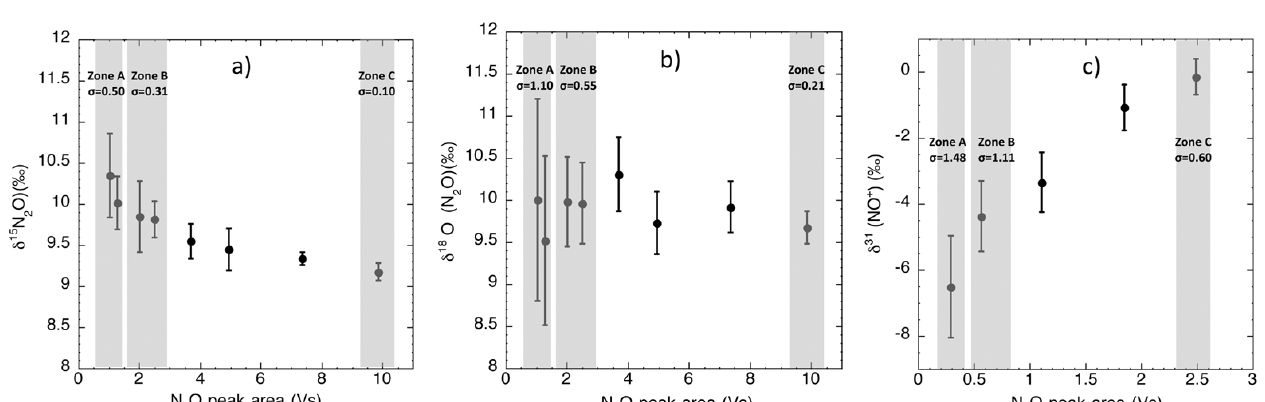
Fig. 3. Results from linearity tests for N 2 O isotopologues carried out twice a week during one month. Various amounts of reference air were introduced directly to the N 2 O IRMS system. Zone A corresponds to peak areas where the small ice core samples of B30 were measured (350–480g). Zone B corresponds to the “optimal zone” where larger ice samples ( ∼ 500–700g) are measured. Zone C corresponds to standard reference air measurements. (a) δ 15 N(N 2 O) (b) δ 18 O(N 2 O) (c) δ 15 N(NO +